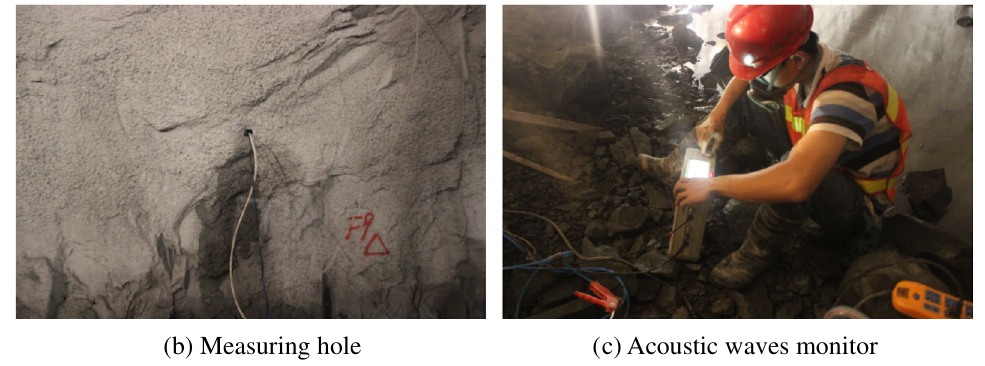
Figure 4. Acoustic wave test of loosening surrounding rock